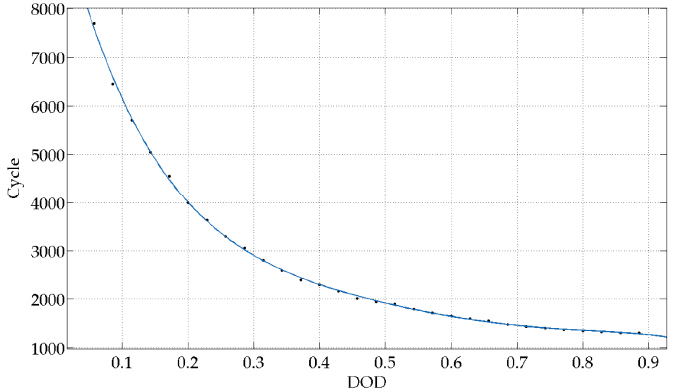
Figure 2. Cycle time of lead ‐ acid batteries. DOD, depth of discharge.